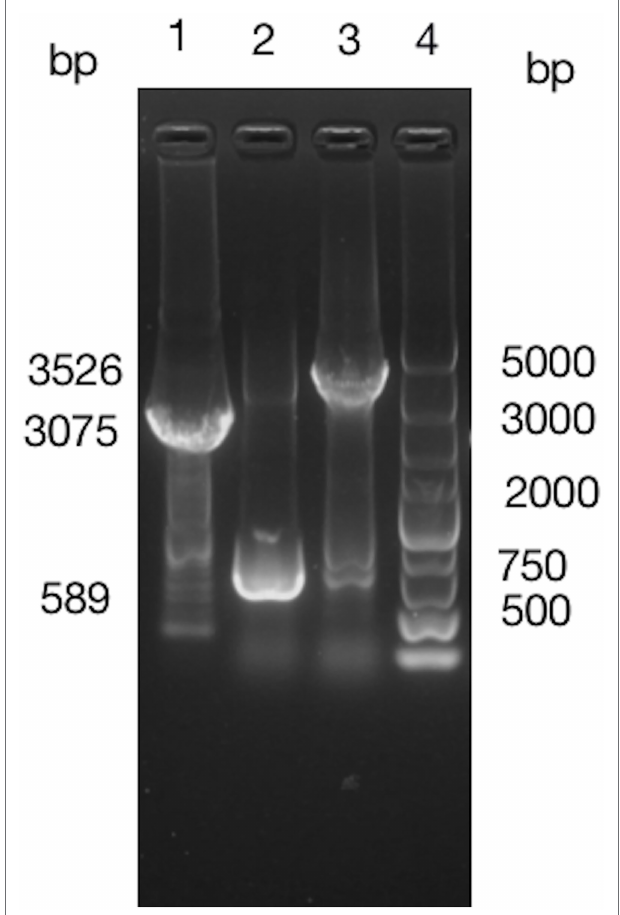
FIGURE 1 | Around 1% agarose gel electrophoresis of PCR products indicates a successful construction of p-telR-RS14560 vector. The AmpR fragment in the p-RS14560 plasmid is replaced by telR cassette amplified from the pMo130telR vector. Lane 1: PCR products of telR cassette; lane 2: PCR products of p-RS14560 plasmid as negative control, lane 3: PCR products of positive clone, and lane 4: DNA marker 5,000 bp.